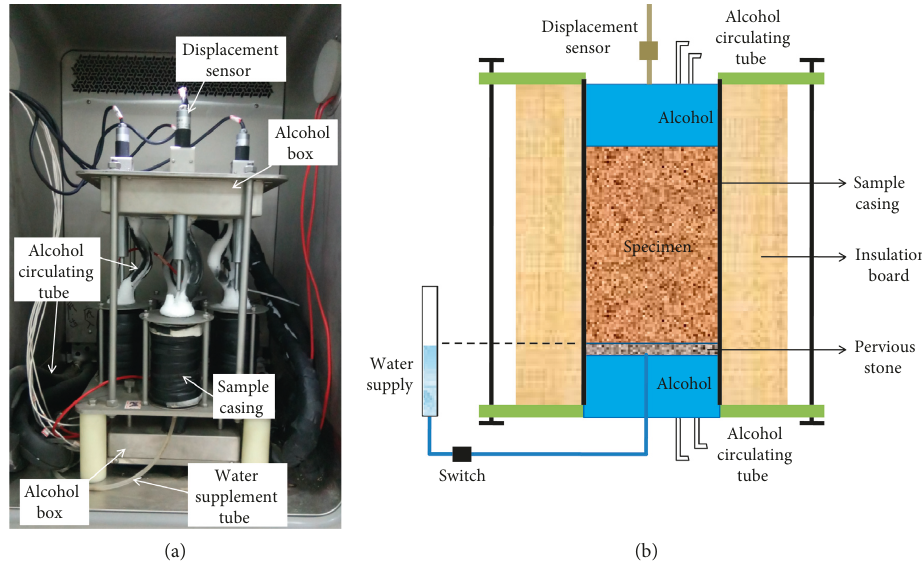
Figure 2: Apparatus for the freeze-thaw test. (a) Environmental chamber. (b) Schematic diagram.